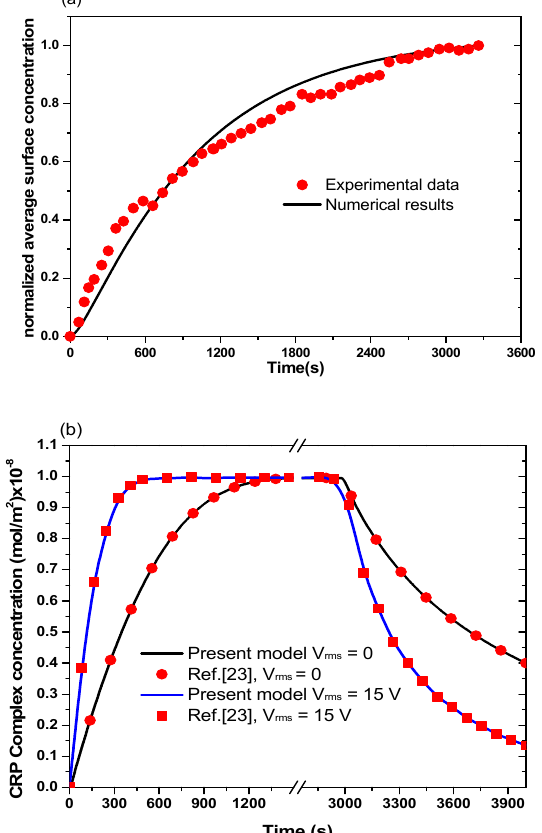
Figure 2. Numerical results of C-reactive protein (CRP) complex concentration as a function of time ( a ) compared to experimental data from Hofmann et al. [13] and ( b ) compared to results from Huang et al. [23] with and without electrothermal force.